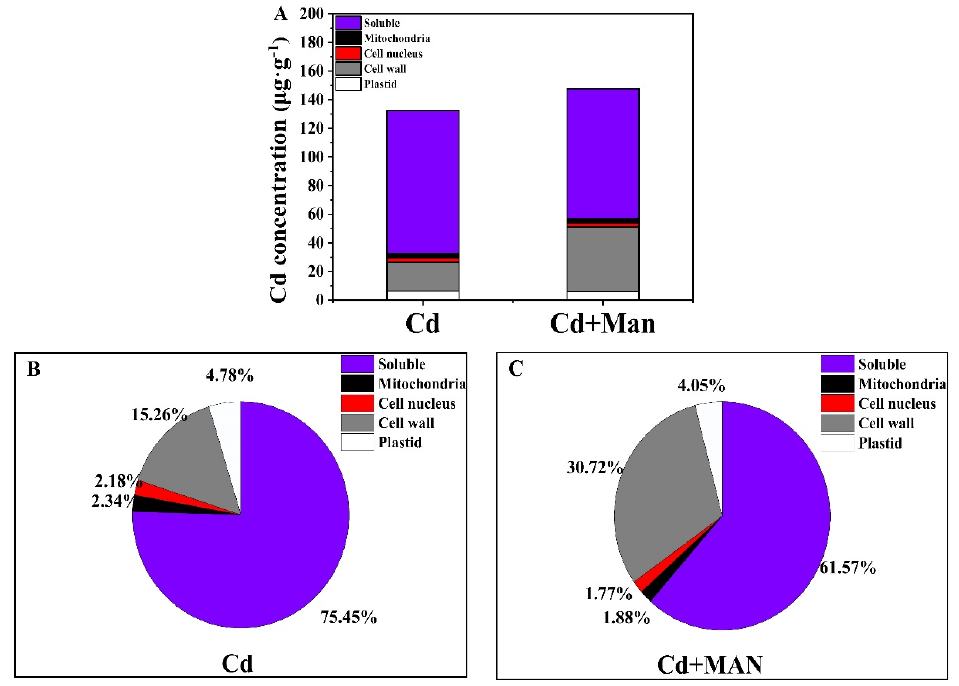
Figure 4. Effect of MAN on the Cd concentration ( A ), and the subcellular distribution of Cd ( B , C ) in wheat roots. One ‐ week ‐ old wheat seedlings under 20 μ M CdCl 2 were sprayed with 0 or 160 μ M MAN for two weeks.